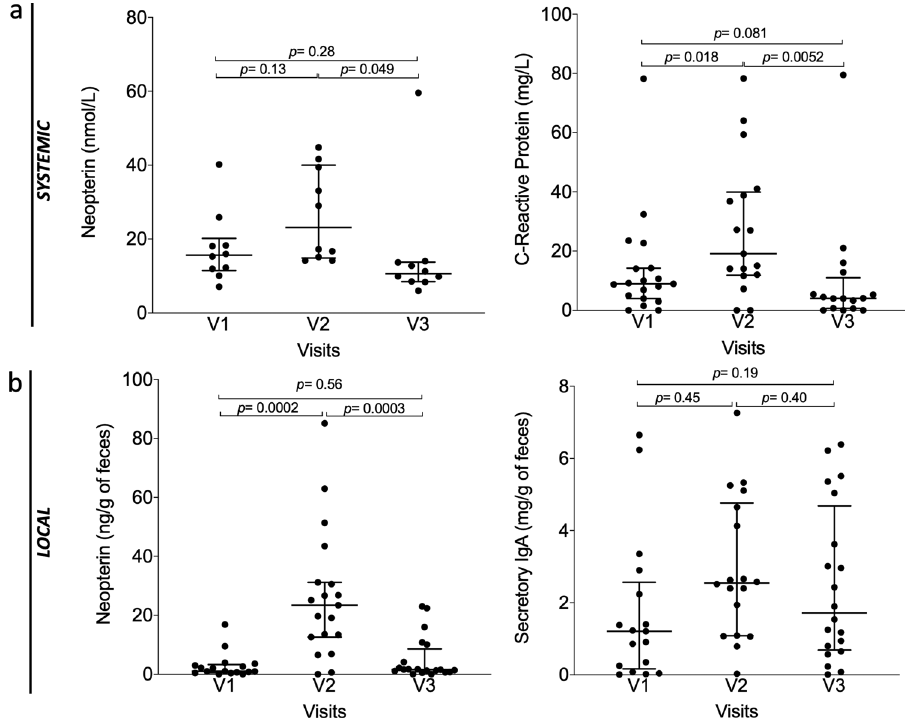
Fig. 5 Evolution of biochemical and immunological parameters in per-protocol patients ( n = 20). a Systemic level in blood, from left to right: neopterin, C-Reactive Protein ( P -value were determined by two-sided signed-rank Wilcoxon paired test, no adjustments were made for multiple comparisons, error bars indicate median and interquartile range, for neopterin n = 10). b Local levels in feces: neopterin, secretory immunoglobulin A (IgA, P -value were determined by two-sided signed-rank Wilcoxon paired test, no adjustments were made for multiple comparisons, error bars indicate median and interquartile range). Source data are provided as a Source Data fi